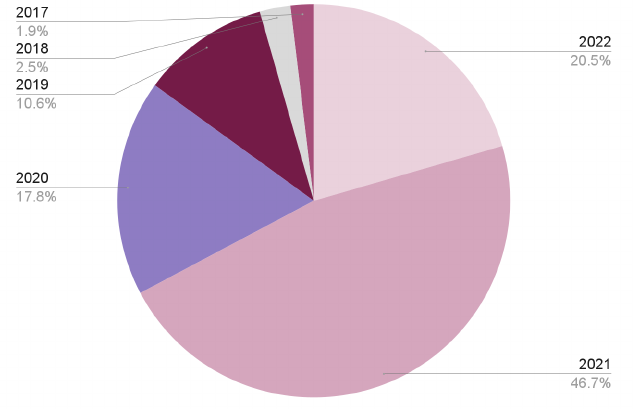
Figure 5. Reviewed papers distribution per